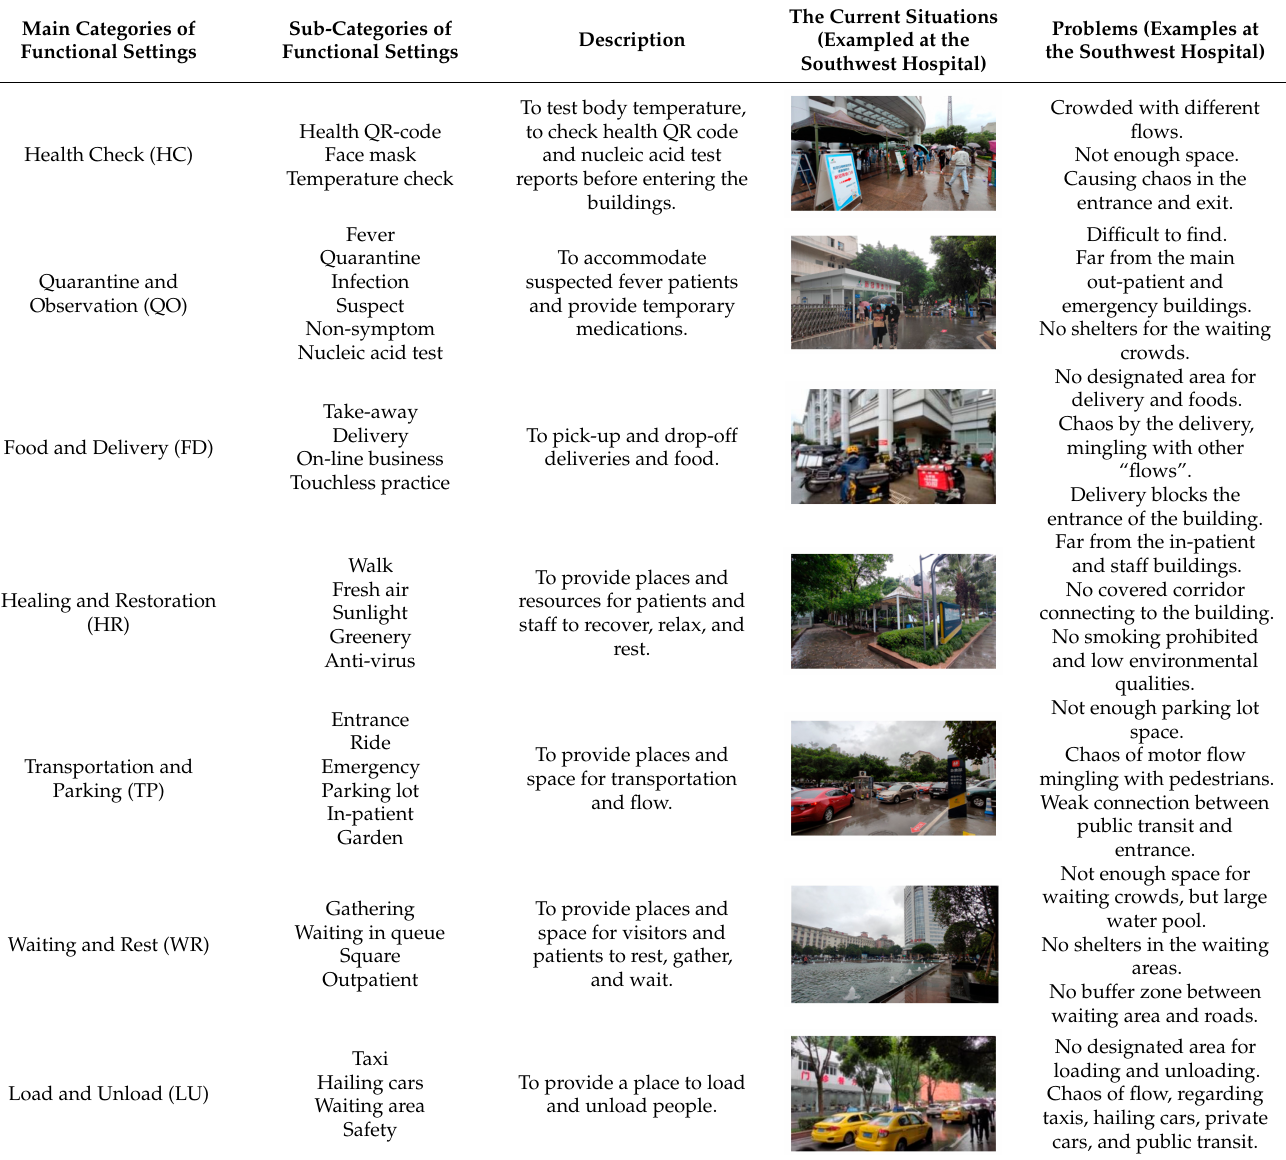
Table 2. Functional settings of outdoor